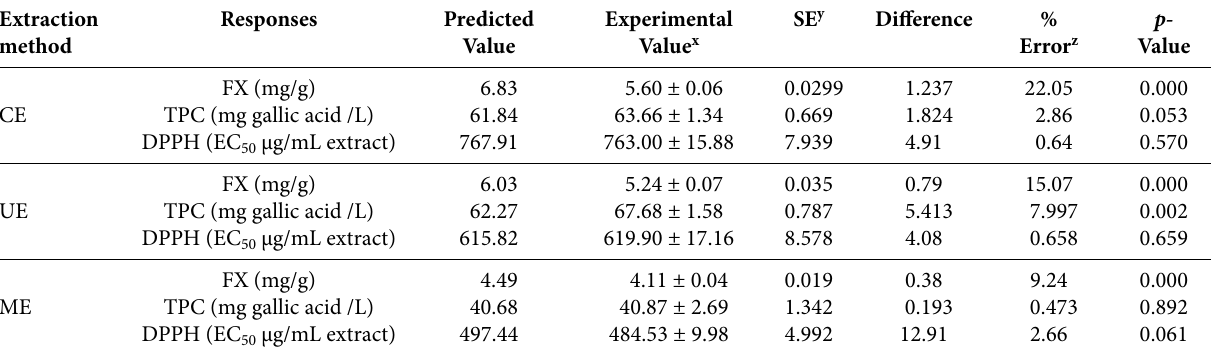
Figure 2. Calculated effects of ultrasound extraction process variables on fucoxanthin content (mg/g), total phenolic content (mg gallic acid /L) and antioxidant activity (EC 50 µg/mL extract). Table 4. Results of statistical analysis for verification of optimization